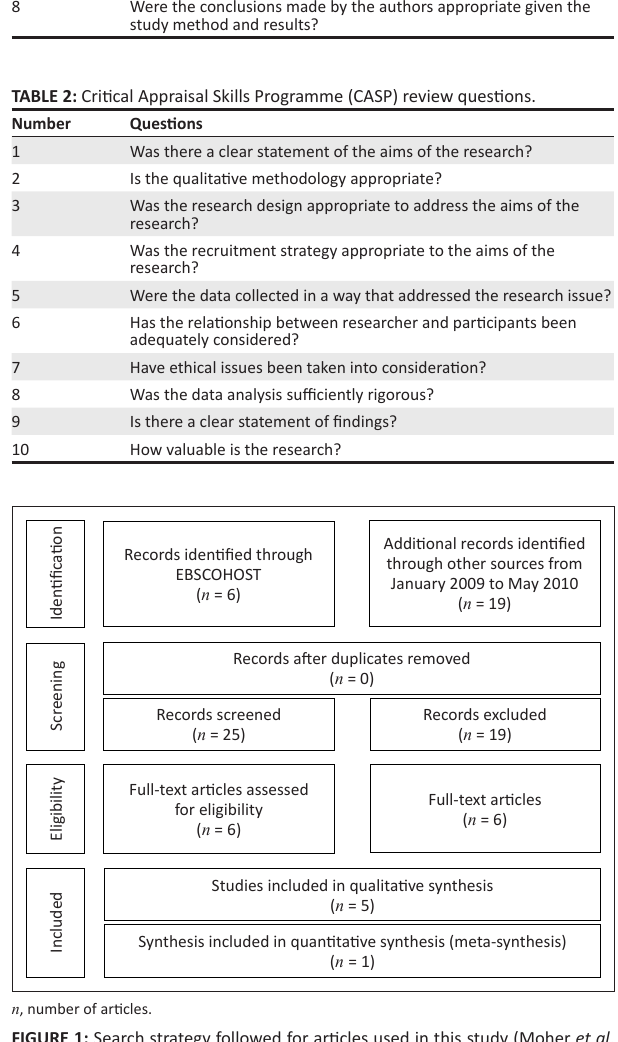
FIGURE 1: Search strategy followed for articles used in this study (Moher et al .